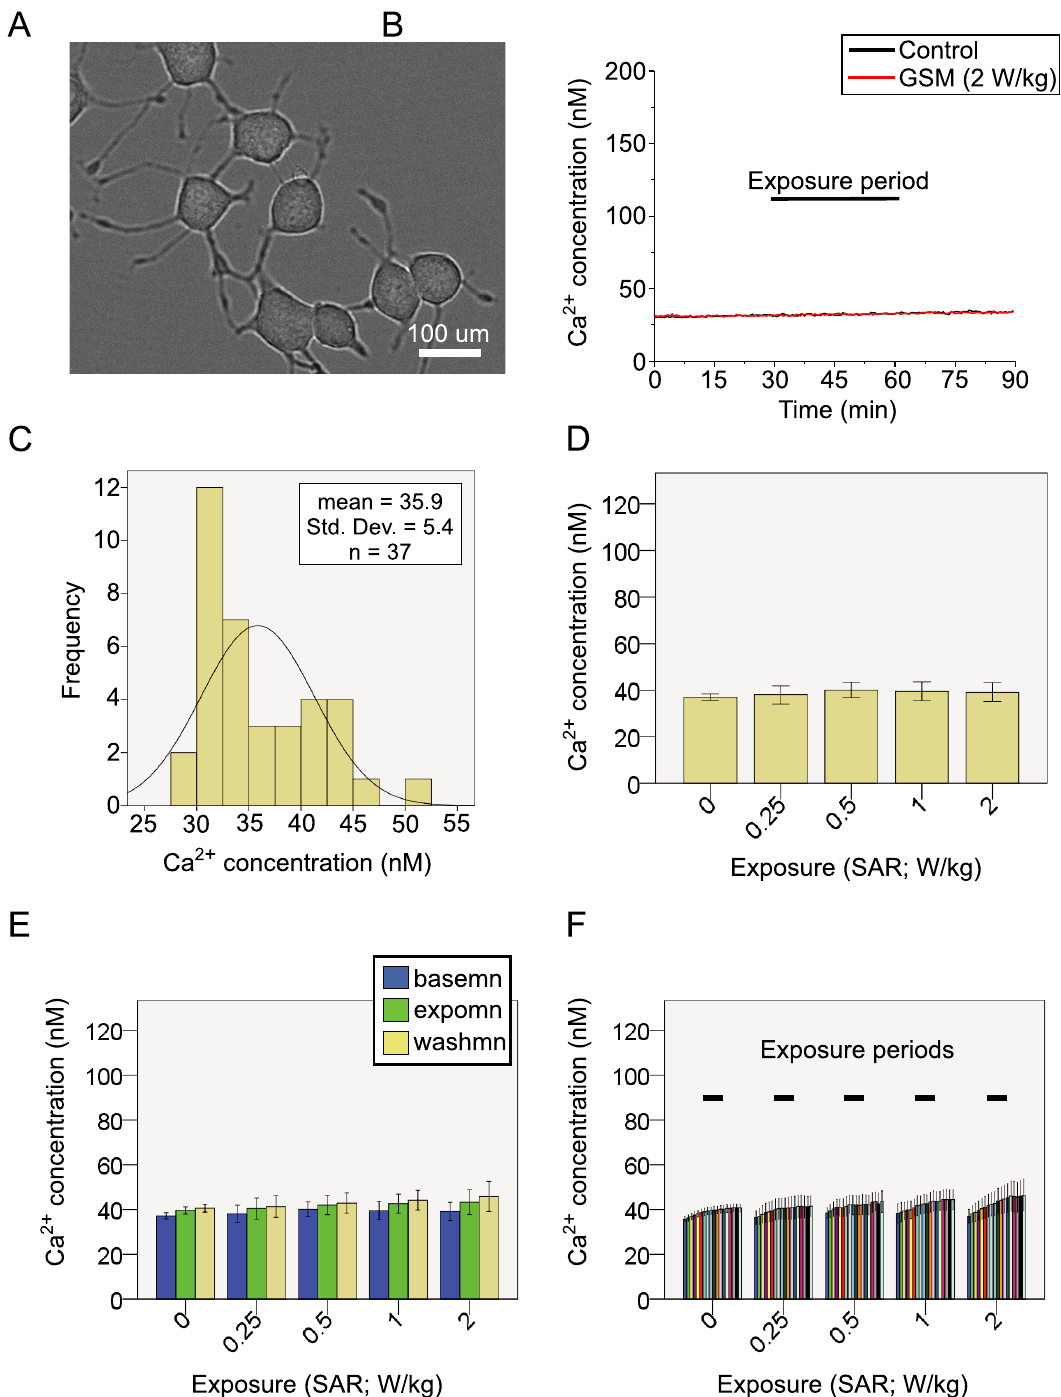
Figure 7. RF Exposure has no influence on Ca 2 + in PC12 cells. A ; Image of differentiated cultured rat PC12 cells shown under phase contrast microscopy. B ; Sample trace showing the experimental protocol. The traces show the Ca 2 + concentration for two coverslides that were simultaneously imaged. One coverslide was exposed to a GSM RF field of 2 W/kg and other was placed in the non-energized TEM cell. C ; the Ca 2 + concentration in PC12 cells was normally distributed. D ; the mean Ca 2 + concentration during the exposure period was compared across groups according to SAR. Exposure had no influence on the Ca 2 + concentration, as there were no differences observed between any of the SARs and the control coverslides (F(4,35)=0.243, p=0.912). E ; the baseline, exposure and washout periods were considered in a repeated measures analysis of variance for changes in Ca 2 + concentration over these times. No significant differences were found in the change of Ca 2 + concentration between these periods that were attributable to the SAR of the RF exposure (F(4.5,35.2)=0.578, p=0.7, Greenhouse-Geiser corrected). F ; smaller temporal bins were computed to elucidate any transient effects that might be smeared by averaging over the 30-minute periods. No significant differences were observed in the change of Ca 2 + concentration over time for the SARs considered, when 5 minute temporal bins were used (F(10.79,83.58)=0.817, p=.621, Greenhouse-Geiser corrected).